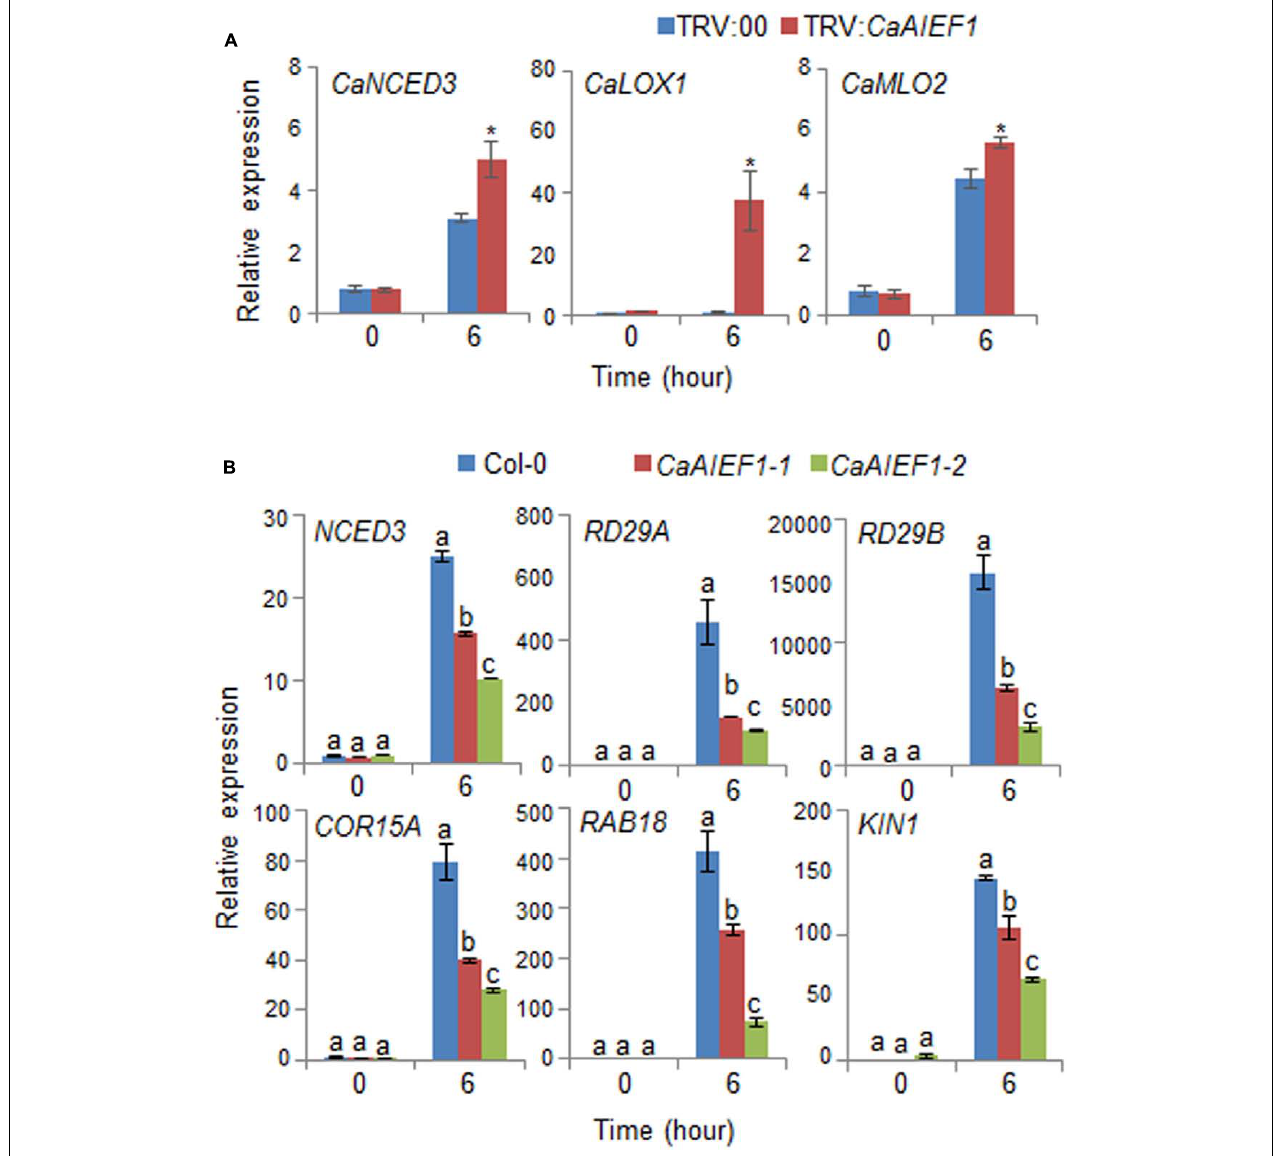
FIGURE 6 | Quantitative real-time polymerase chain reaction (qPCR) analysis of stress-responsive genes in the leaves of CaAIEF1 -silenced pepper plants (A) and CaAIEF1 -OX transgenic Arabidopsis (B) plants exposed to drought stress; analysis was performed 6 h after detachment. The relative expression levels ( (cid:49)(cid:49) CT) of each gene were normalized to the geometric mean of pepper Actin1 and Arabidopsis Actin8 as internal control genes. Data represent the mean ± standard error of three independent experiments. Different letters indicate significant differences between wild-type and transgenic lines ( P < 0.05; ANOVA followed by Fisher’s LSD